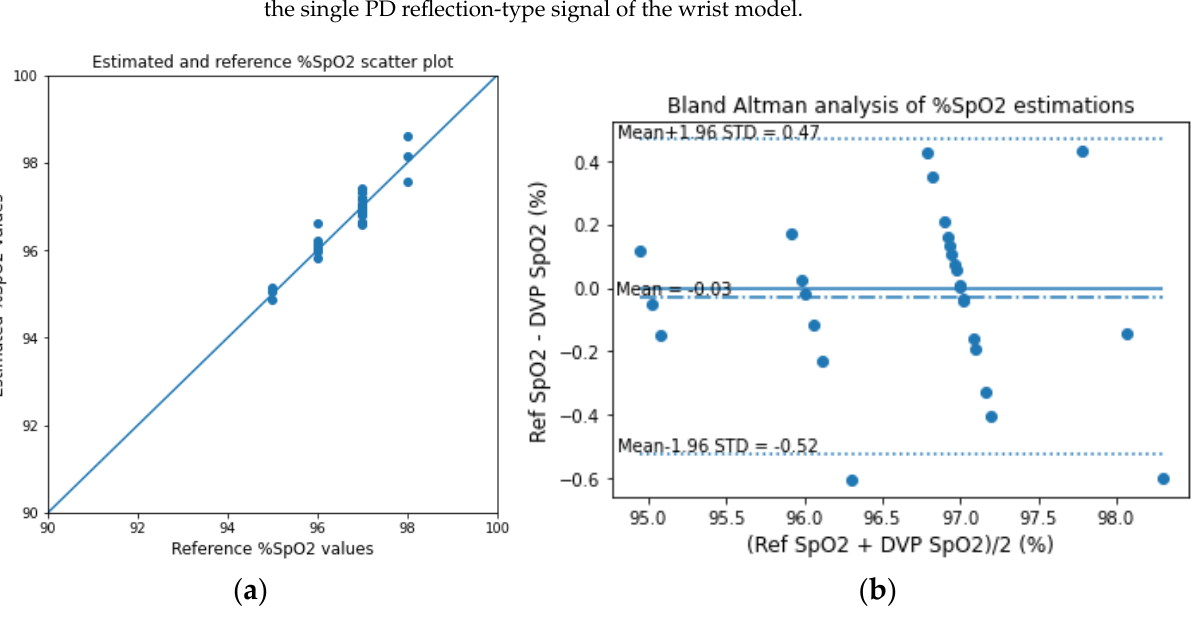
the single PD reflection-type signal of the wrist model.